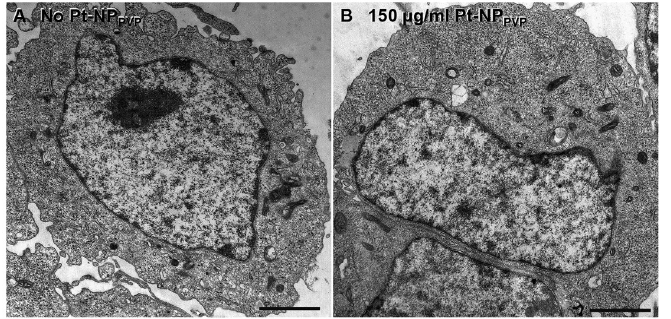
Fig 3. Ultrastructure of the HEI-OC1 cells following exposure to Pt-NP PVP . HEI-OC1 cells were cultivated either without Pt-NP PVP incubation as reference (A) or in culture medium containing 150 μ g/ml of the Pt-NP PVP (B). No cytotoxic effect of Pt-NP PVP could be found. The HEI-OC1 cells contained a few mitochondria und single endoplasmic reticulum profiles. Their endocytic activity was low. No Pt-NP PVP were recognized on the cell surface or inside the cytosol. Size of the bars: 2 μ m.